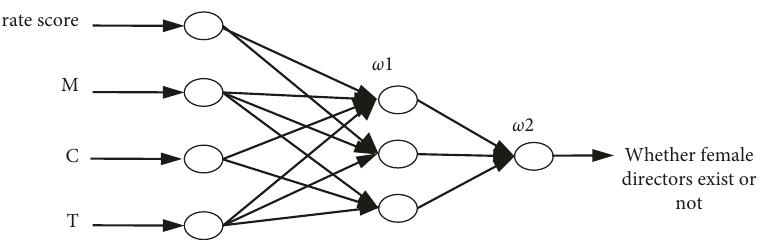
Figure 2: The network structure of prediction model.